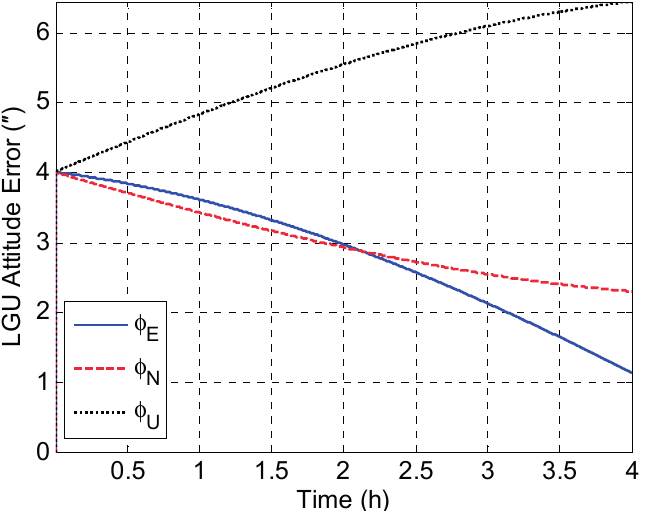
Figure 9. LGU attitude error introduced by initialization error.